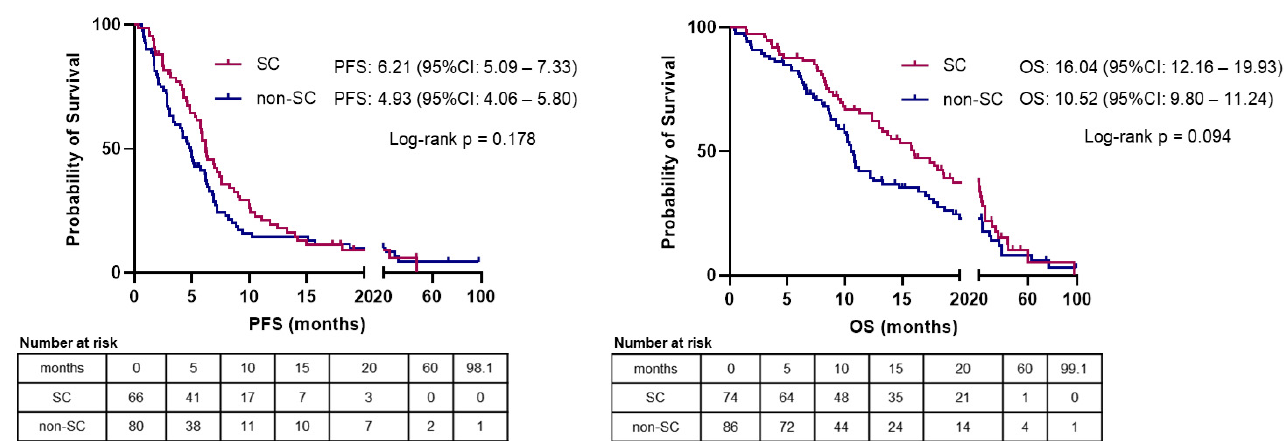
Figure 3. Kaplan–Meier curves for progression-free survival (PFS) and overall survival (OS) according to the morphological subtype in patients with advanced-stage extra-pulmonary neuroendocrine carcinoma in this study. PFS and OS in the graphs refer to median values calculated by Kaplan–Meier analysis. Log-rank p = p value calculated by applying Log-rank test (Mantel-Cox) for the equality of survival distributions. Table 2. Univariable and multivariable Cox-regression analysis for PFS and OS in patients with advanced extra-pulmonary neuroendocrine carcinoma in this study.